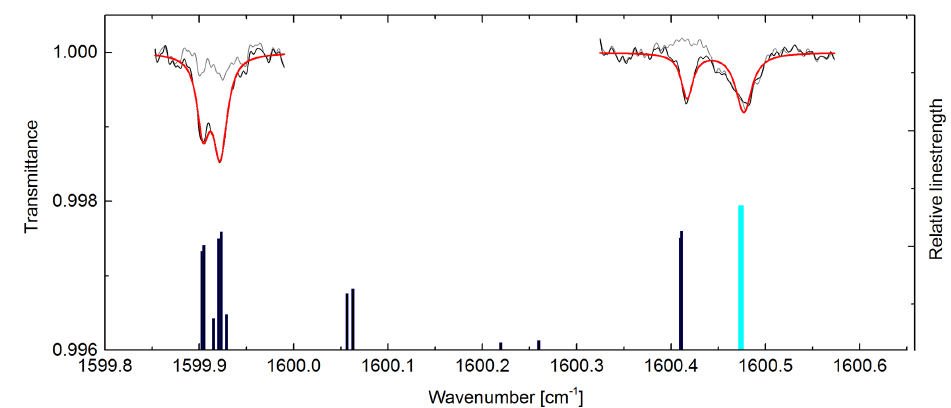
Figure 2. Transmission spectra recorded by the instrument: NO 2 -scrubbed air (grey) and ambient air with 49ppb of NO 2 (black). Both samples contained 0.5% water. The red trace represents the least-square fit to the ambient air spectrum. The dark blue and light blue bars indicate the line strength of NO 2 and H 2 O absorption lines, respectively.